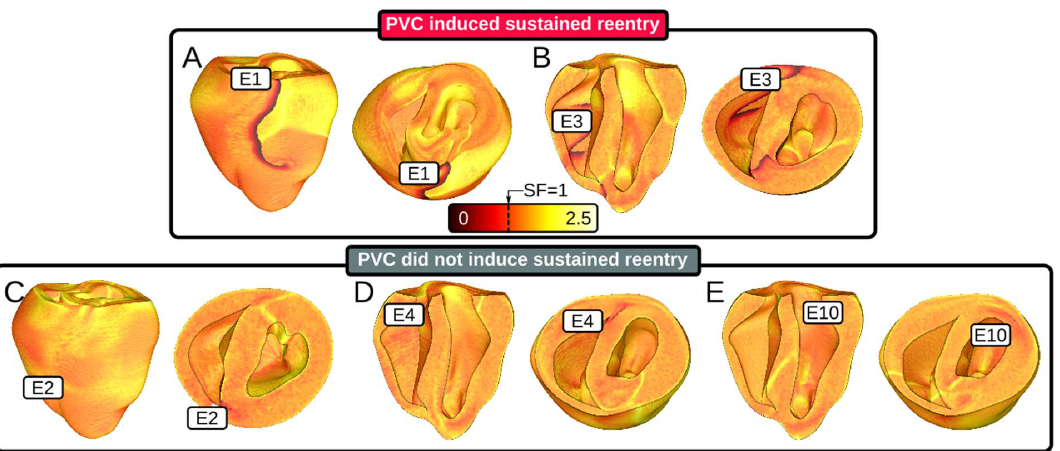
Figure 5. Maps of SF for propagation during the first excitation cycle following ectopic stimulation from several different sites in simulations with 30% of normal I Na . Thick lines of critical SF (black/red: SF , 1) indicate locations of conduction block. (A–B) PVCs analyzed here induced sustained reentry ( . 1000 ms ). Lines of critical SF were present along the septal insertion. (C–E) PVCs analyzed here did not induce reentry. SF: safety factor.